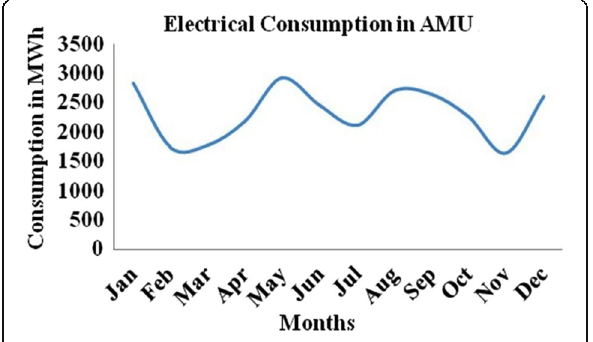
Fig. 1 Electrical consumption in AMU for 2016